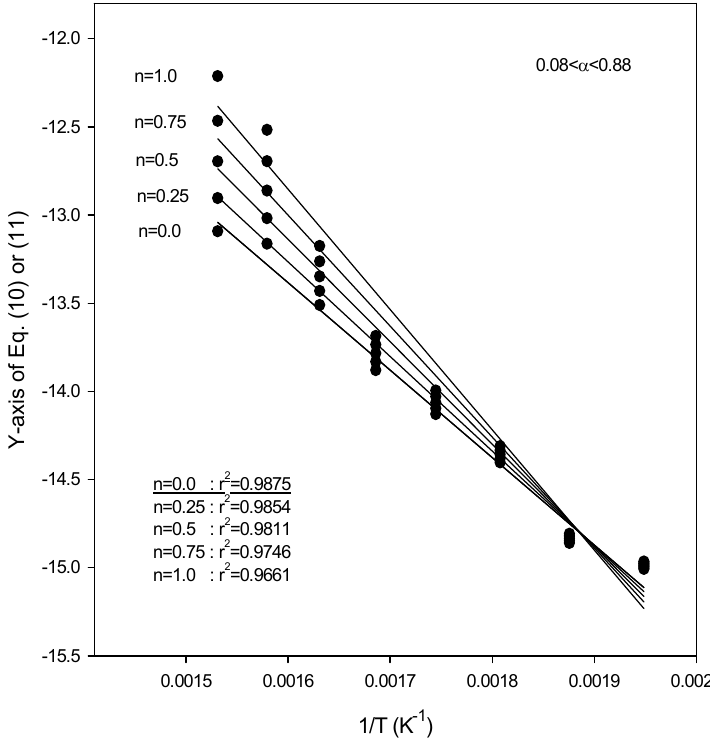
Figure 6. Plots of Equations (10) or (11) for the application of the kinetic analysis method at a heating rate of 14.5 °C/min for SCE.